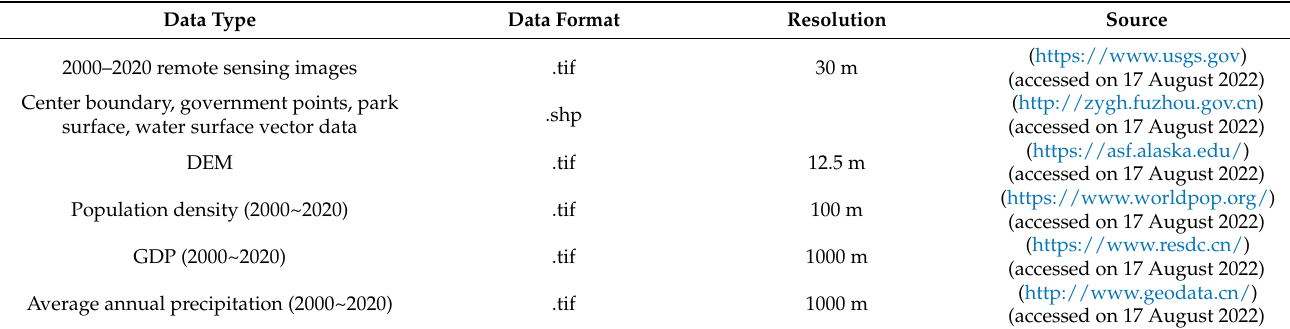
Table 1. Data sources.